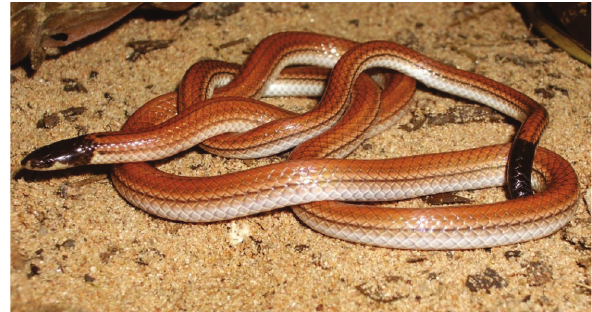
Figure 10. Apostolepis vittata . A specimen deposited at the Universidade Federal de Mato Grosso (UFMT-R 12259) from the National Park of Chapada dos Guimarães, Cuiabá, Mato Grosso, Brazil (photo by Christine